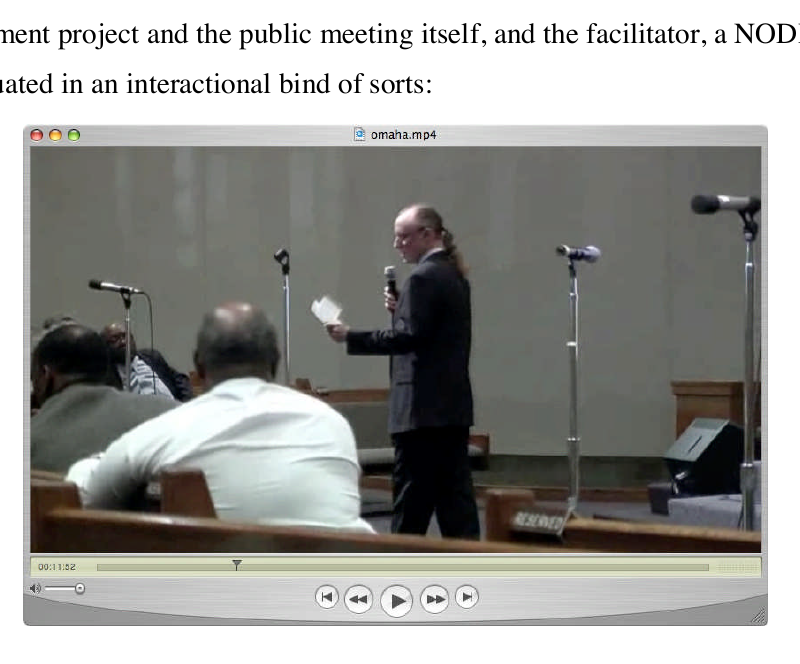
Figure 11: Facilitator Bob Peters reading a Question